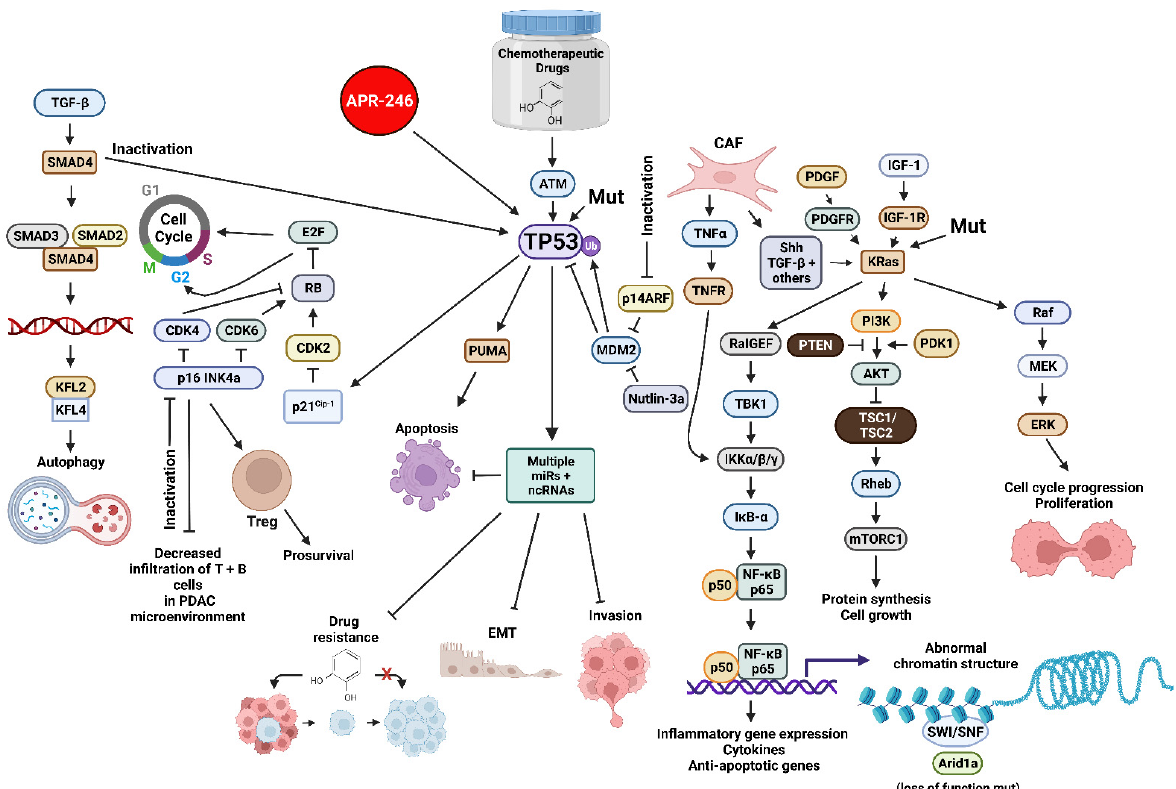
Figure 1. Sites of Interactions of Mutant Genes in PDAC and the Various Pathways which they Effect and also Sites of Interaction of Certain Small Molecule Inhibitors Discussed in this Review. Abbre- viations: transforming growth factor- β (TGF- β ), small mothers against decapentaplegic homolog 4 protein (SMAD4), small mothers against decapentaplegic homolog 3 protein (SMAD3), small moth- ers against decapentaplegic homolog 2 protein (SMAD2), Kruppel-like factor 4 (KLF4), Kruppel-like